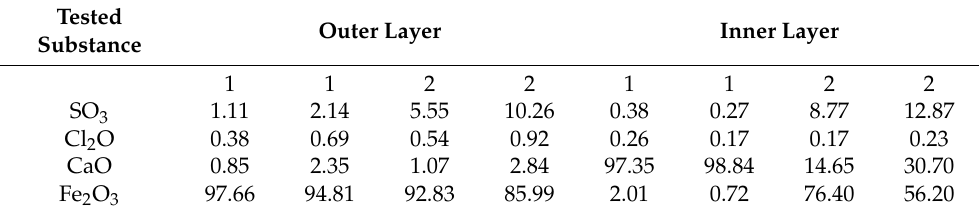
Table 3. Chemical composition of the sediment in the outer layer and inner layer.